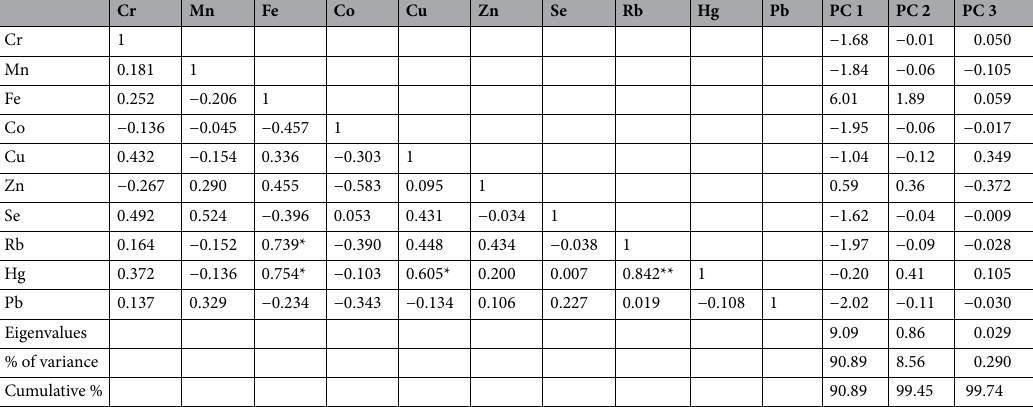
Table 6. Pearson’s correlation coefficient between the determined heavy metals and the rotated component matrix for PCA. *Correlation was significant at p < 0.05. **Correlation was significant at p < 0.01.